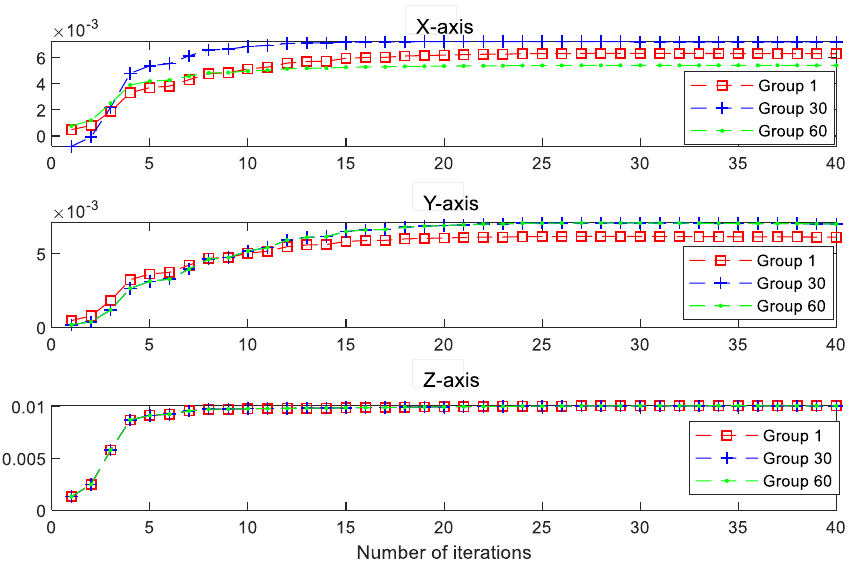
Figure 2. Gyroscope meter − scal − factor estimation results. The second column in Table 2 estimates the installation error, scale factor error, and zero-bias error of the accelerometer from the conventional system-level calibration. The third column estimates each error value of the accelerometer from the distributed method. The fifth column estimates the installation error, scale factor error, and zero-bias error of the gyroscope using the conventional method. The sixth column estimates the error values of the gyroscope using the distributed method. The zero-bias errors of the gyroscope and accelerometer are analyzed. We give the random drift of the gyroscope as 1, 2, and 3 degrees/h, and the zero-bias stability of the accelerometer as 1, 2, and 3 mg, respectively. The zero-bias error parameters of the accelerometer obtained using the traditional method are 0.9993, 1.9997, and 3.0007, while the parameters obtained using the distributed algo- rithm are 0.9965, 1.9904, and 3.0132. The zero-bias errors of the gyroscope obtained using the conventional method are 0.9967, 2.0007, and 2.9994. The parameters obtained using the distributed algorithm are 1.0668, 2.1194, and